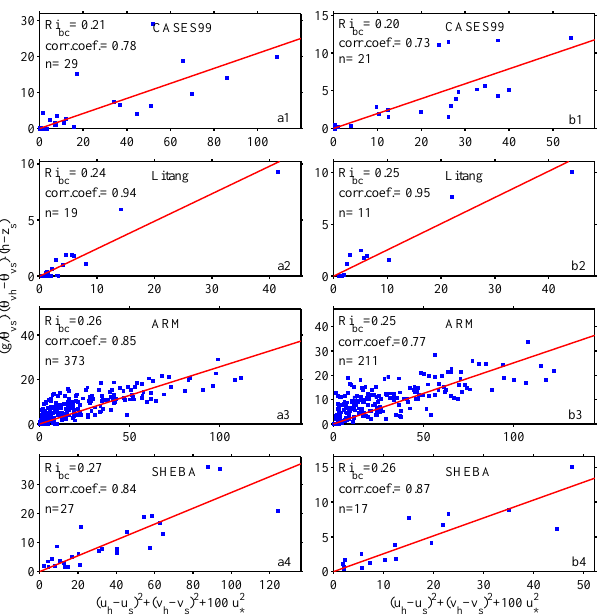
Figure 4. Linear fitting method inferred Ri bc for type I SBLs, with z s = 40m (left) and z s = 80m (right). The red solid lines are the best linear fittings and their slopes represent the values of Ri bc .